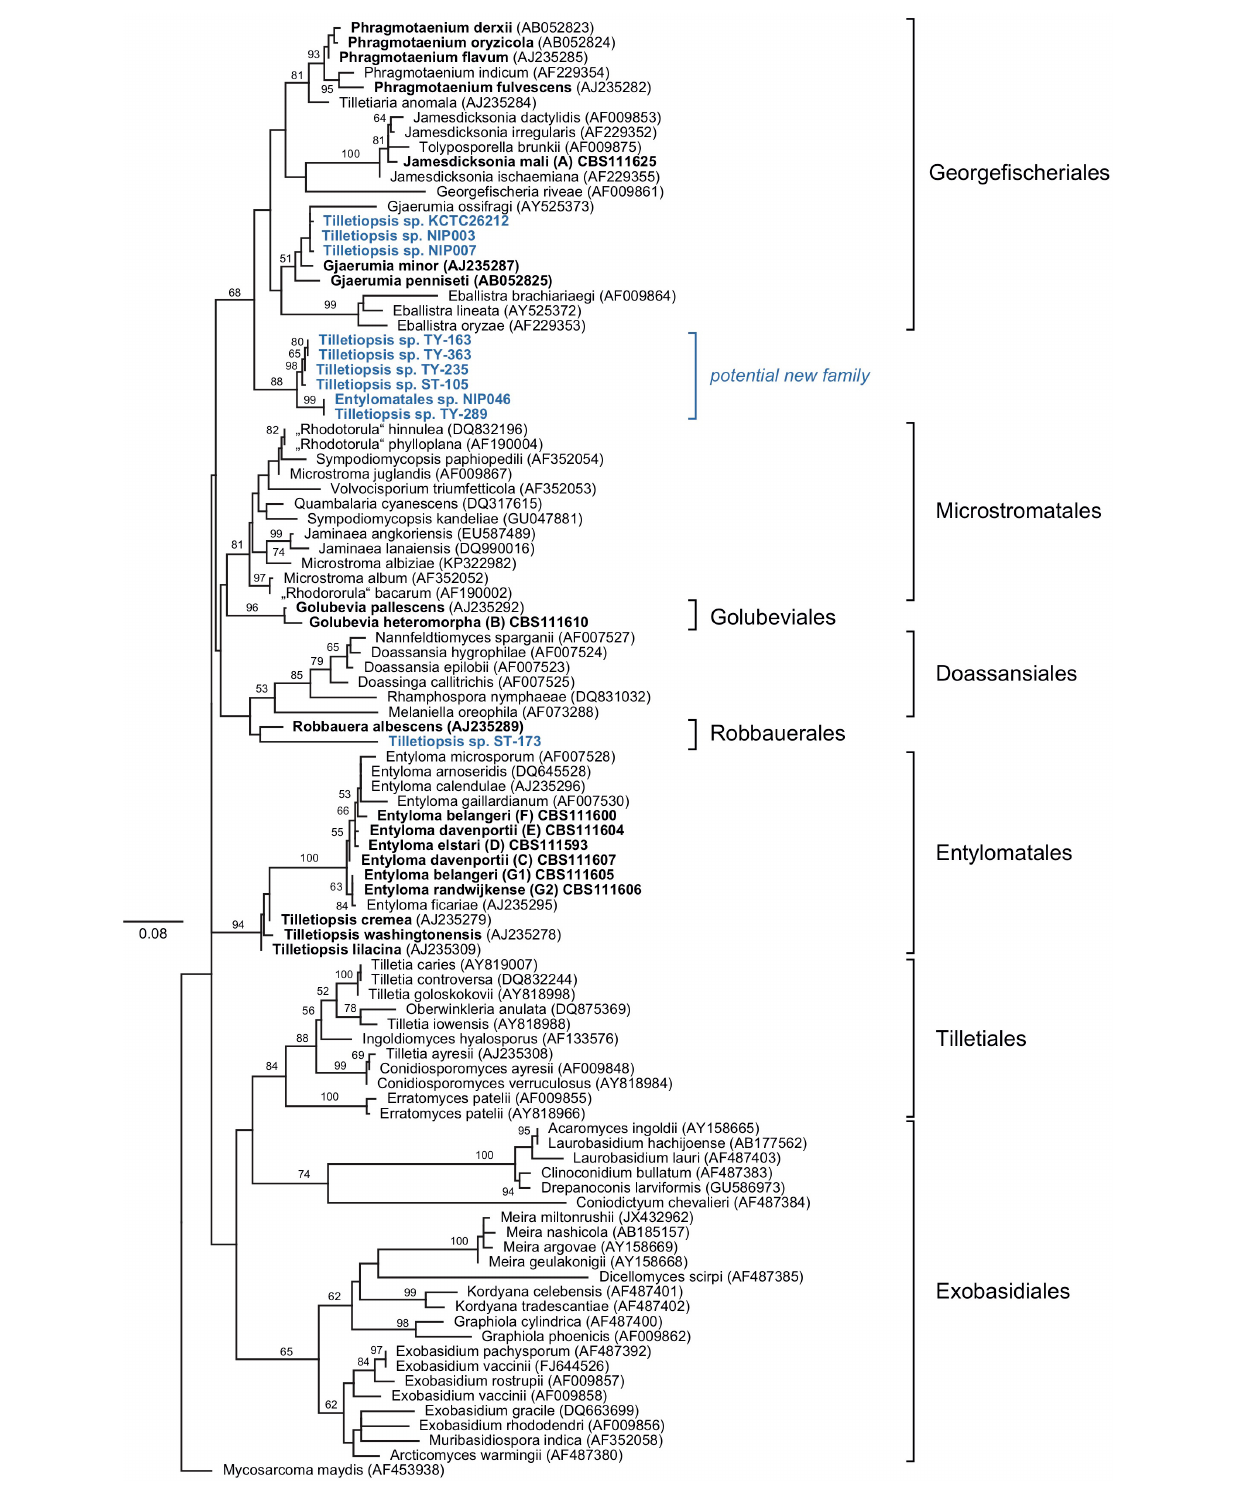
Frontiers in Microbiology |